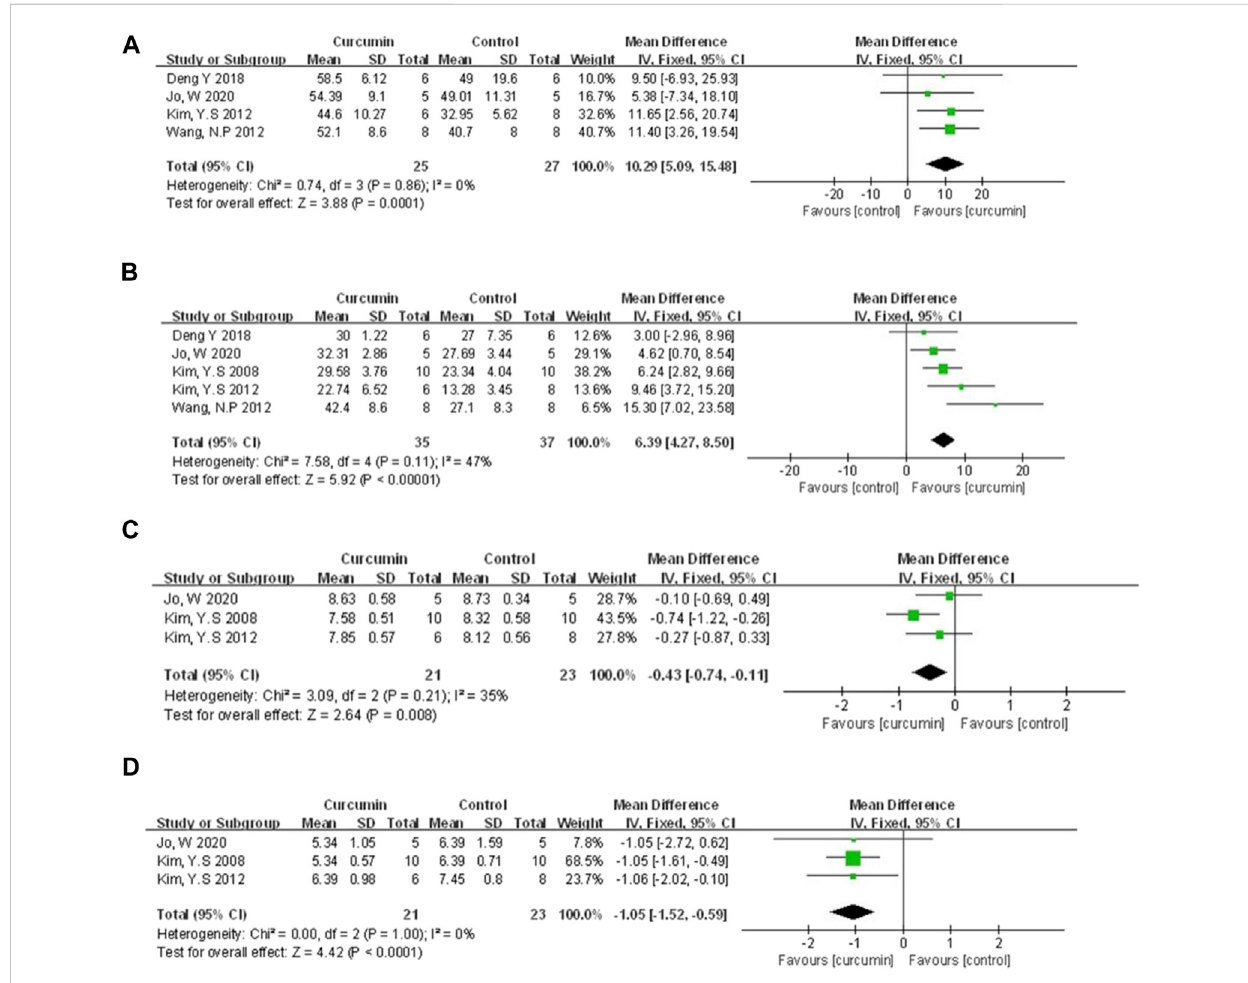
FIGURE 4 (A) The meta-analysis results of the effect of curcumin on LVEF (B) The meta-analysis results of the effect of curcumin on LVFS. (C) The meta- analysis results of the effect of curcumin on LVDd. (D) The meta-analysis results of the effect of curcumin on